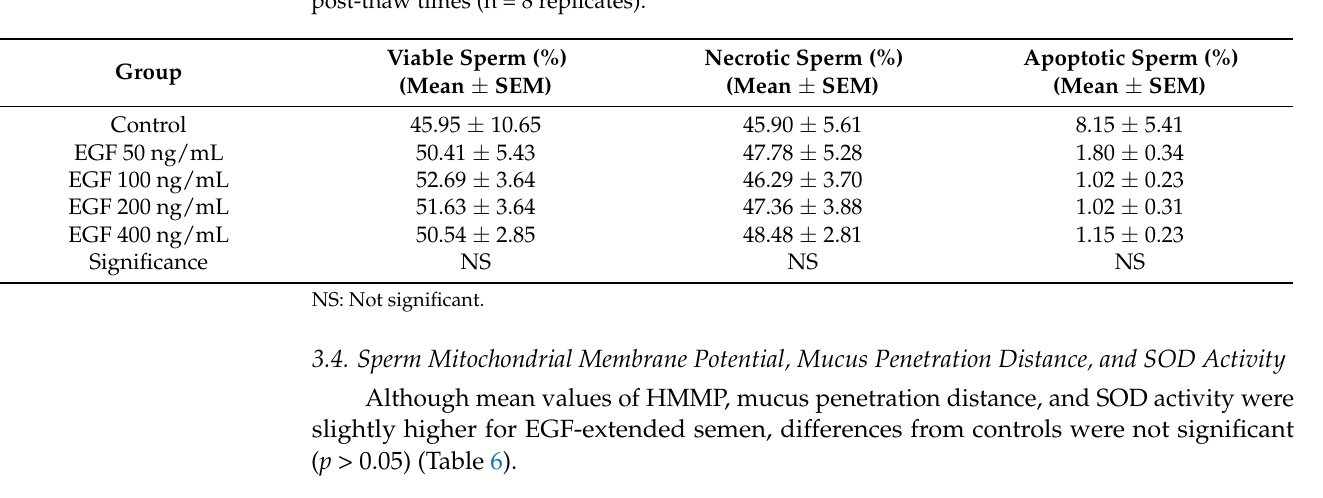
Table 6. Differences in sperm mitochondrial membrane potential, mucus penetration distance, and SOD activity between thawed semen extended with epidermal growth factor (EGF) at different concentrations (50, 100, 200, and 400 ng/mL) and controls (without EGF) at different post-thaw times (n = 8